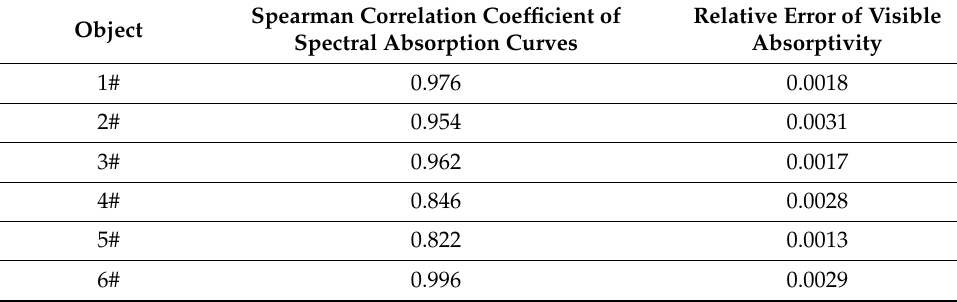
Figure 13. Spectral absorption curves determined based on weighted Gaussian, uniform, and Cauchy distribution models and those obtained experimentally. Table 4. Comparison of calculation and measurement